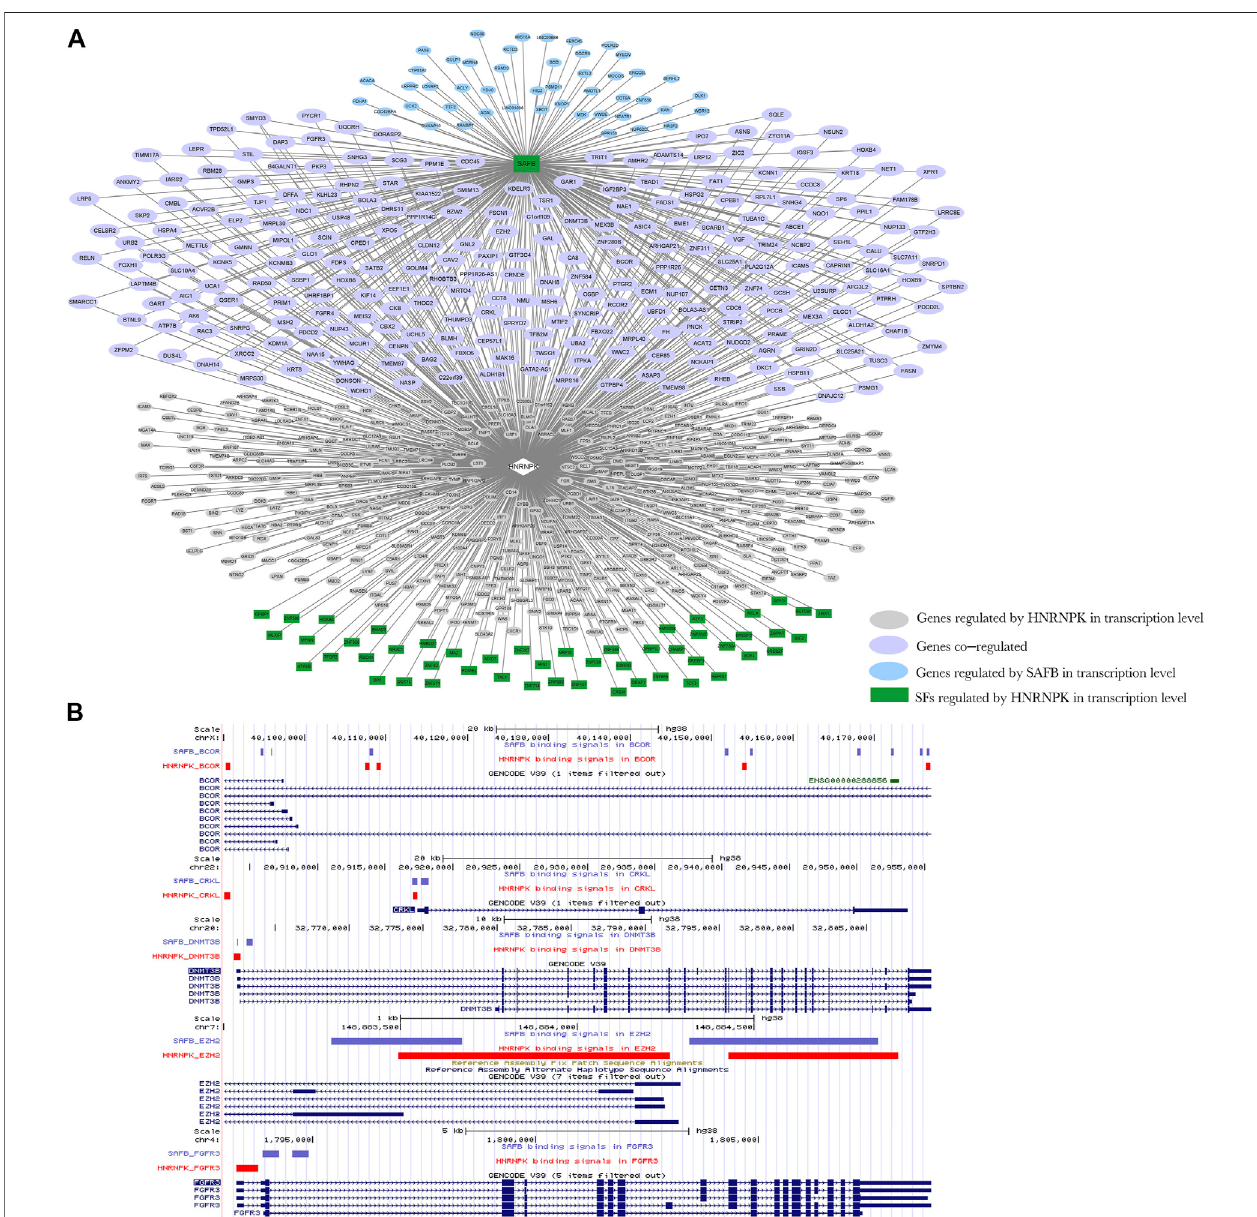
FIGURE8| Networkdiagramofregulationmodel Ⅲ . (A) HeterogeneousnuclearribonucleoproteinK(HNRNPK)regulatesthesplicingofscaffoldattachmentfactor B1(SAFB);HNRNPKandSAFBcanjointlyregulatethetranscriptionofdownstreamgenes.GreenindicatesgenesthatactastranscriptionfactorsregulatedbyHNRNPK atthesplicinglevel,pinkindicatesgenesregulatedbyHNRNPKatthetranscriptionallevel,blueindicatesgenesregulatedbySAFBatthetranscriptionallevel,andpurple indicatesgenesco-regulatedbyHNRNPKandnuclearcap – bindingproteinsubunit2(NCBP2)atthetranscriptionallevel.EllipsesindicatethetargetgenesofSAFB and HNRNPK at the transcriptional level, and rectangles indicate target genes of HNRNPK at the splicing level. (B) The binding regions of HNRNPK and SAFB in transcriptional regulation target genes, BCL6 corepressor, CRK-like proto-oncogene adaptor protein, DNA methyltransferase 3 beta, enhancer of zeste 2 polycomb repressive complex 2 subunit, and fi broblast growth factor receptor 3. Input the ChIP-seq data of HNRNPK and SAFB into the UCSC Genome Browser to obtain the position image of peak in the genome. Purple and red indicate the protein binding sites, and blue indicates the location of genes in the genome. For more detailed information on genes in the network, please refer to Supplementary Table S9